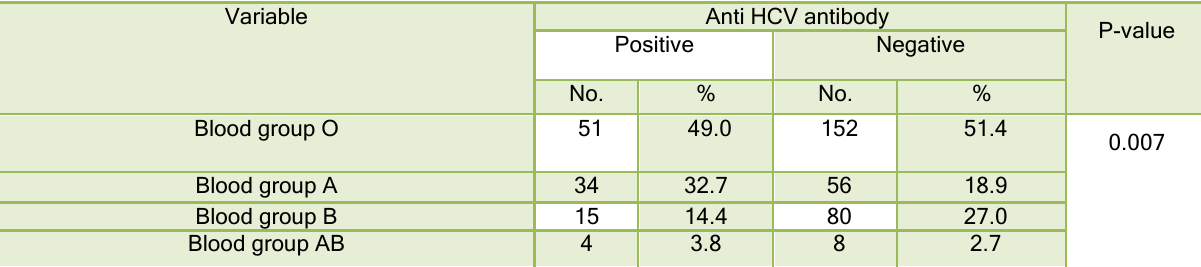
Table 6: The relationship of blood group with occurrence of HCV.